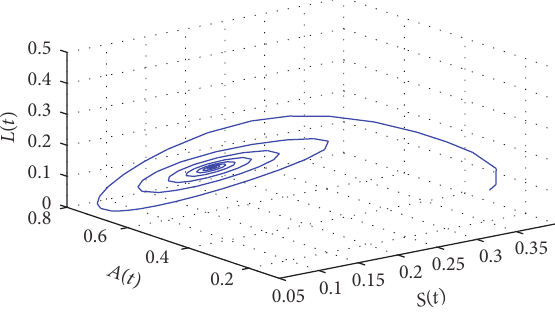
Figure 14: The phase plot of states 𝑆 ∗ , 𝐿 ∗ , and 𝐴 ∗ with 𝜏 1 = 8.65 < 𝜏 = 65.25 18.6255 = 𝜏 󸀠 2 10 and